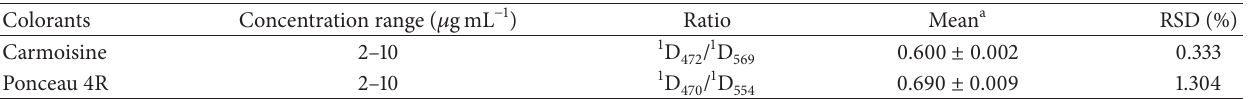
Table 1: Experimental parameters calculated for the simultaneous determination of Carmoisine and Ponceau 4R in binary mixture by compensation method.